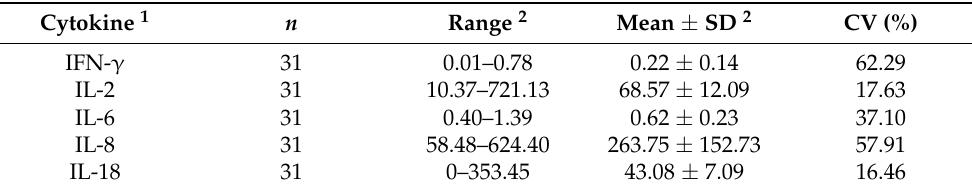
mean ± standard deviation (SD), and coefficient of variation (CV).